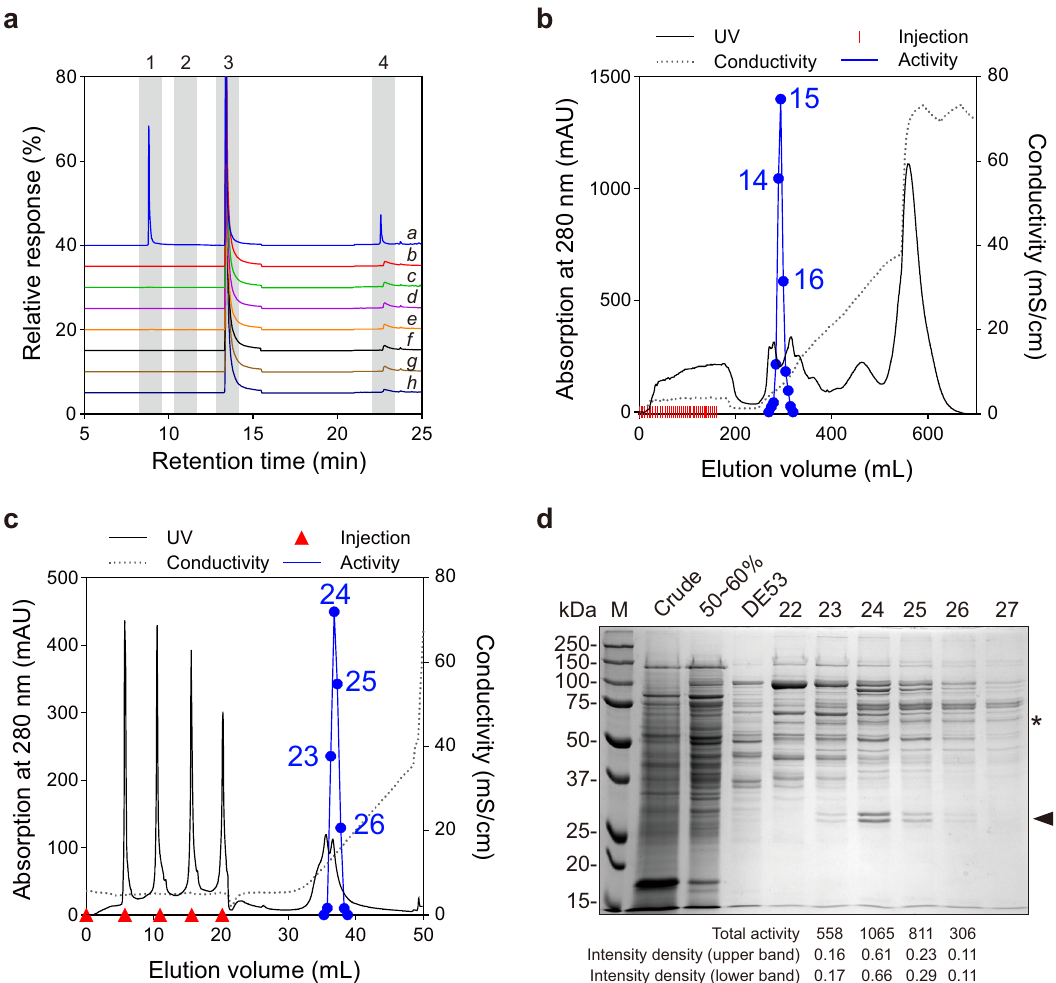
Fig. 3 Partial puri fi cation of native PhBS from petunia fl owers. a GC – MS analysis of BS activity in petunia fl ower crude protein extracts. Substrates and